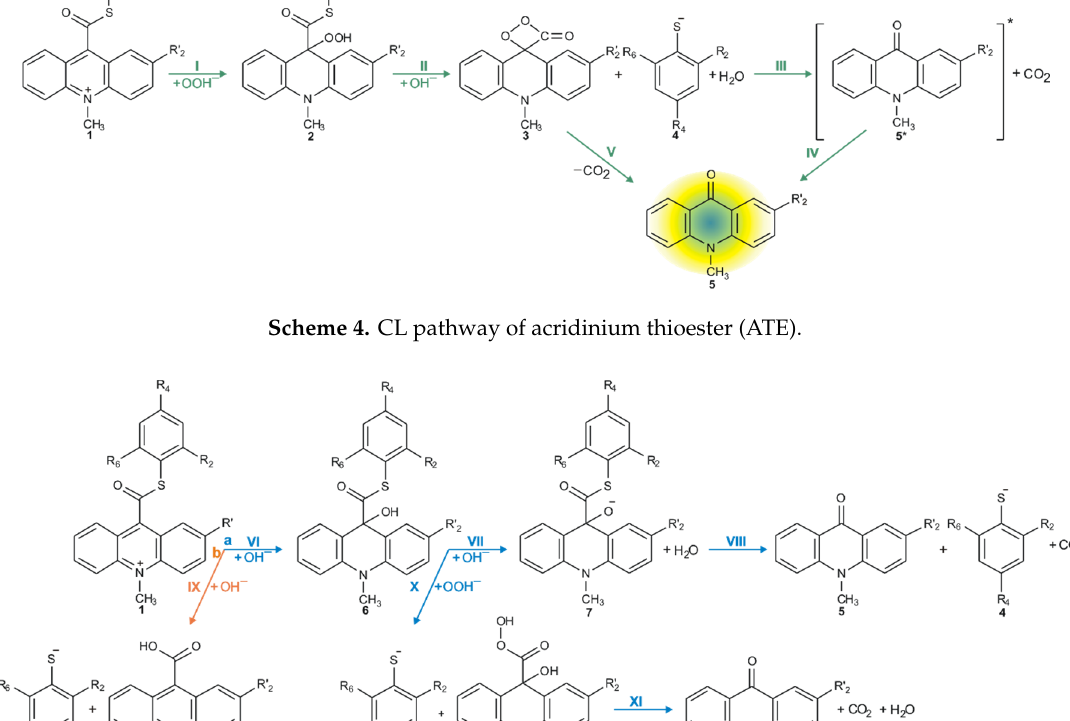
Figure 3. Relative Gibbs free energies of the reaction steps of two possibilities of non-CL pathways of acridinium thioesters: ( a , black) unsubstituted and ( b , blue) substituted in the acridine moiety. Among the compounds investigated, f (electron-acceptor substituent in 4 position of thiophenoxy group), g (two electron-acceptor substituents in 2 and 6 positions of thiophenoxy group) and h (two electron-donor substituents in 2 and 6 positions and electron-acceptor substituent in 4 position of thiophenoxy group) pay attention. The thermodynamic results indicate decrease of Gibbs free energy values compared to the same values for other compounds investigated. The highest decrease can be seen in the case of II (formation of cyclic intermediate 3) and IX (hydrolysis of acridinium cation) steps. It can be assumed, that the addition of an electron-acceptor substituents in 2 and 6 positions or an electron-donor substituents in 2 and 6 position while an electron-acceptor substituent in 4 position, will affect the more efficient transformation into electronically excited product, but also sensitizes to the hydrolysis of ATEs. Considering the utilitarian perspectives of the studied compounds, we compared the energetical values of the main steps (the chemiluminescence pathway and the formation of the pseudobase as affecting the whole process) between acridinium thioesters and currently used in the analysis – acridinium esters. Figure S2 in the Supplementary Materials presents the Gibbs free energy profiles of the CL pathway and the first step of the non-CL pathway (formation of the pseudobase) of acridinium thioesters and acridinium esters. The results show slight differences of the values of Gibbs free energies for step I (addition of OOH – at the C9 atom on acridinium moiety; – 44.8 and – 43.1 kcal mol – 1 for AE and ATE, respectively) and VI (formation of the pseudobase; – 62.8 and – 61.9 kcal mol – 1